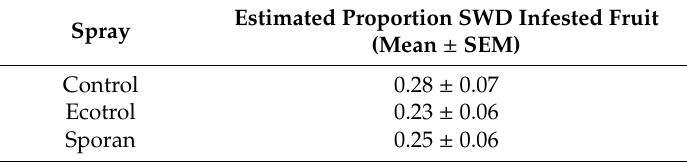
Table 2. Estimated proportion of Drosophila suzukii infested blueberry fruit applied with two botanical volatile organic compounds and grown under two kinds of plastics in a semi-field bioassay. Spray treatments include control, Ecotrol (rosemary, geraniol, peppermint oils), and Sporan (rosemary, cloves, thyme, peppermint oils). Fruit was harvested 4 days after spraying before incubating at 24 degrees Celsius for 7 days to determine proportion of infested fruit per treatment. No significant di ff erences were detected at the α = 0.05